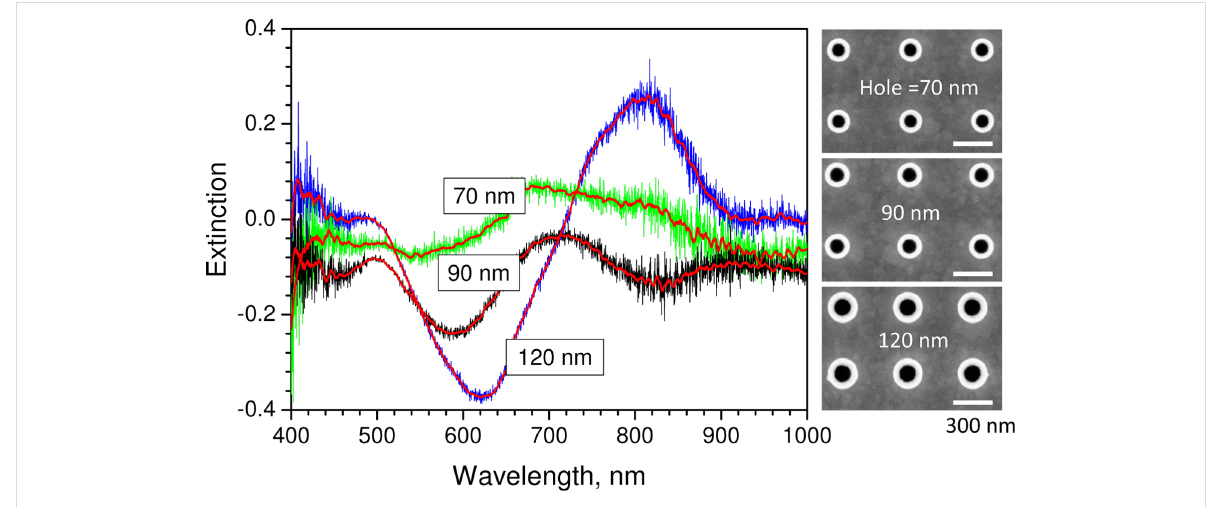
Figure 3: Experimentally measured extinction of the nano-well substrate for hole diameters of 70, 90, and 120 nm. The value is normalized to a continuous 100-nm Au layer, thus the negative regions offer proof of extraordinary transmission [16] through the array.